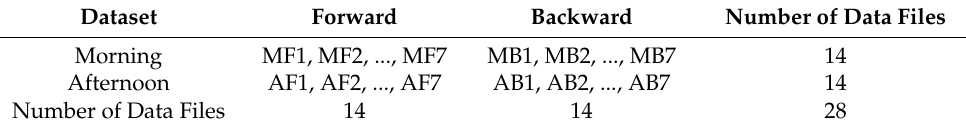
Table 2. Types of